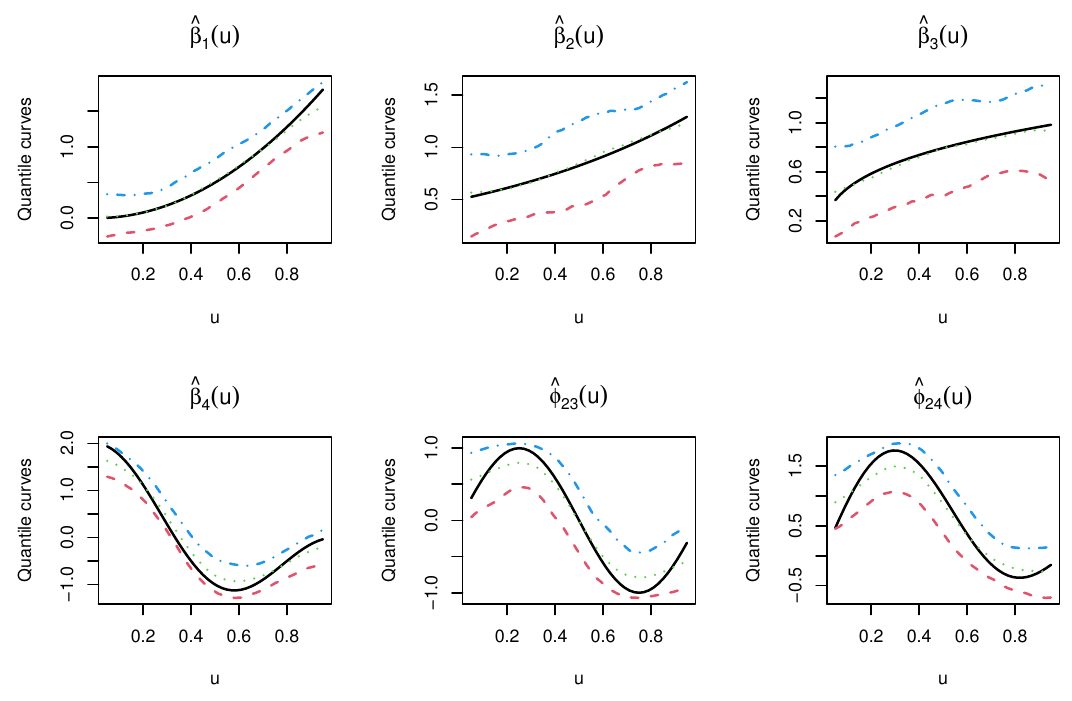
Figure 3. Estimated quantile curves of Model 3. Dash-dot lines are 0.95 quantile curves, dotted lines are 0.50 quantile curves, dashed lines are 0.05 quantile curves, and solid lines are the real function curves. The dash-dot and dashed lines indicate 90% confident